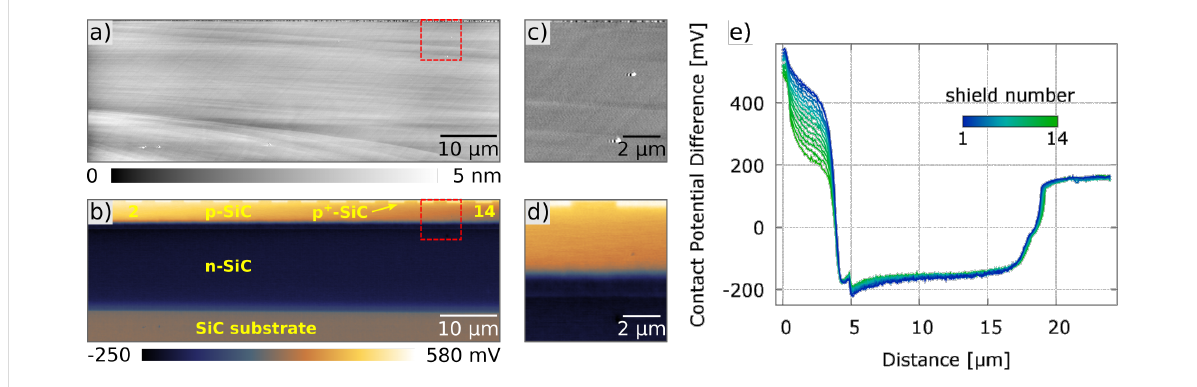
Figure 8: Simultaneously acquired topography (a) and CPD (b) images of a silicon carbide JBS structure. The scan range is 70 × 24 μ m 2 with an arithmetic average roughness of R A = 5 nm. Differently doped regions of the SiC sample are clearly identified in the KPFM-signal. A zoom of the topography and the CPD data marked by the dashed square is shown in c) and d), respectively. Line sections across the different interfaces through each center of a p + -doped area are shown in graph e). The shields (width 2.8 μ m) are numbered from left to right and have a periodicity of 4.9 μ